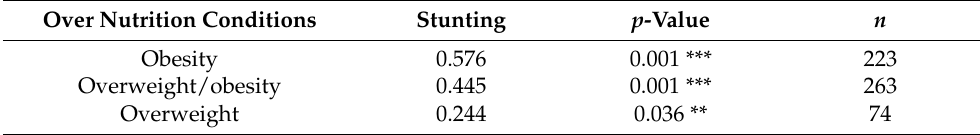
Table 5. Association of stunting and overweight/obesity among children. Over Nutrition Conditions Stunting p -Value n Obesity 0.576 0.001 *** 223 Overweight/obesity 0.445 0.001 *** 263 Overweight 0.244